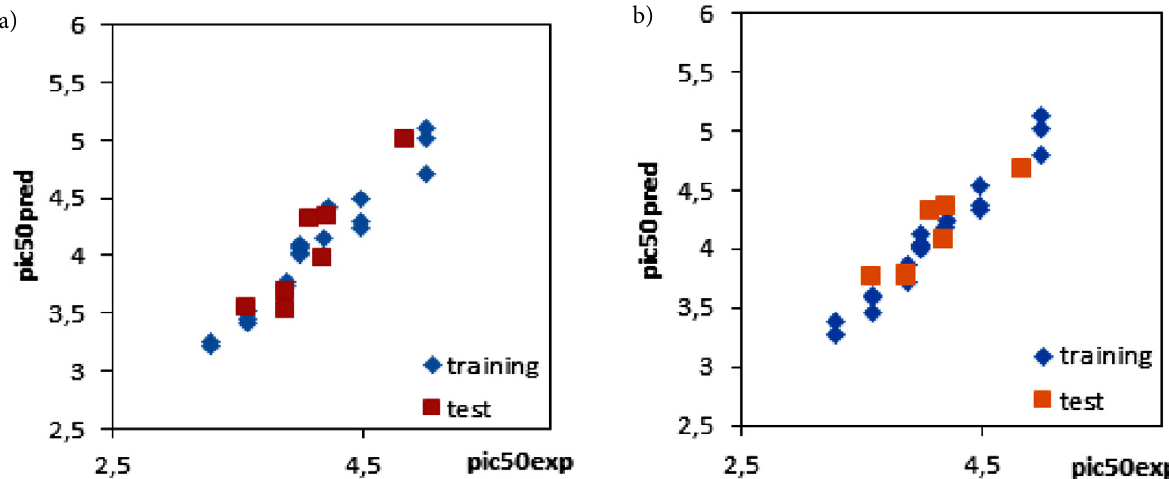
Fig. 3. Graph of staphylococcus aureus inhibitors predicted activity of training and test set from a) CoMFA and b) CoMSIA analysis.